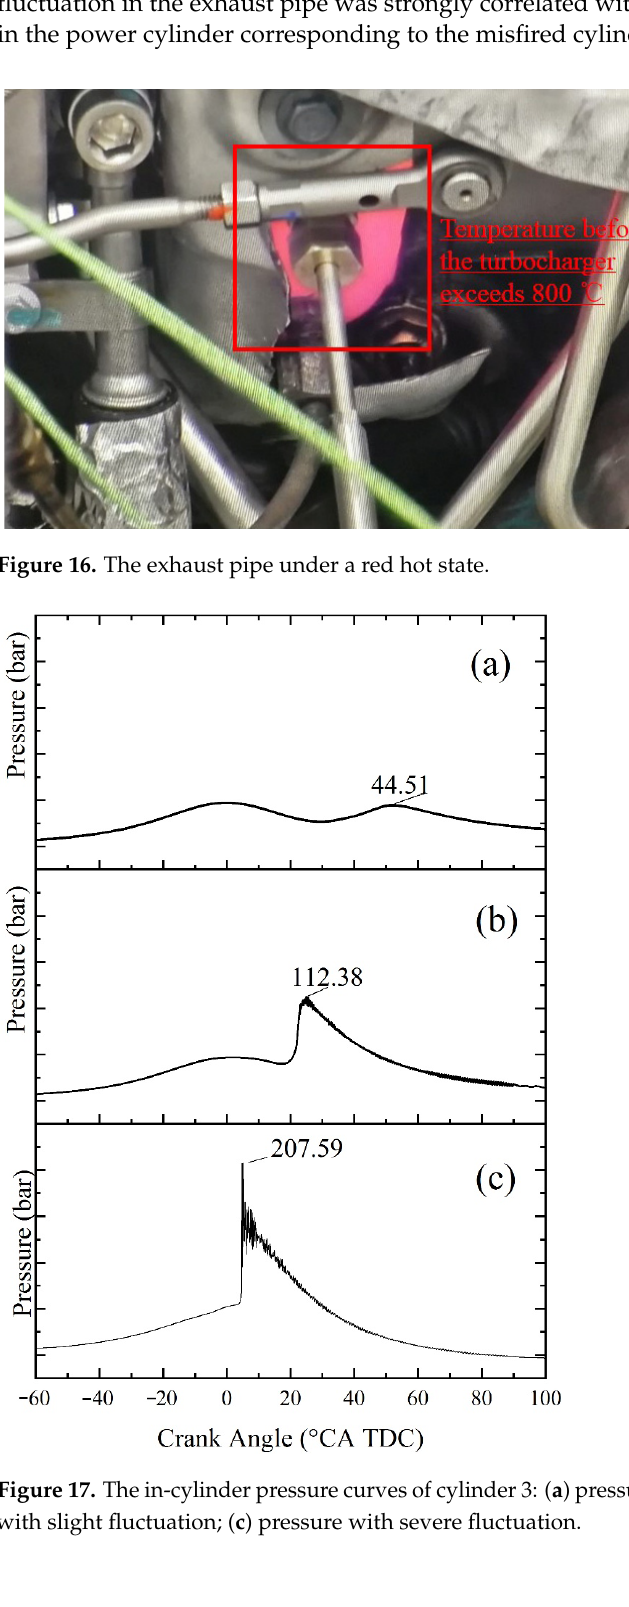
Figure 15. The different types of exhaust pressure fluctuations: ( a ) pressure without fluctuation; ( b ) pressure with slight fluctuation; ( c ) pressure with severe fluctuation.